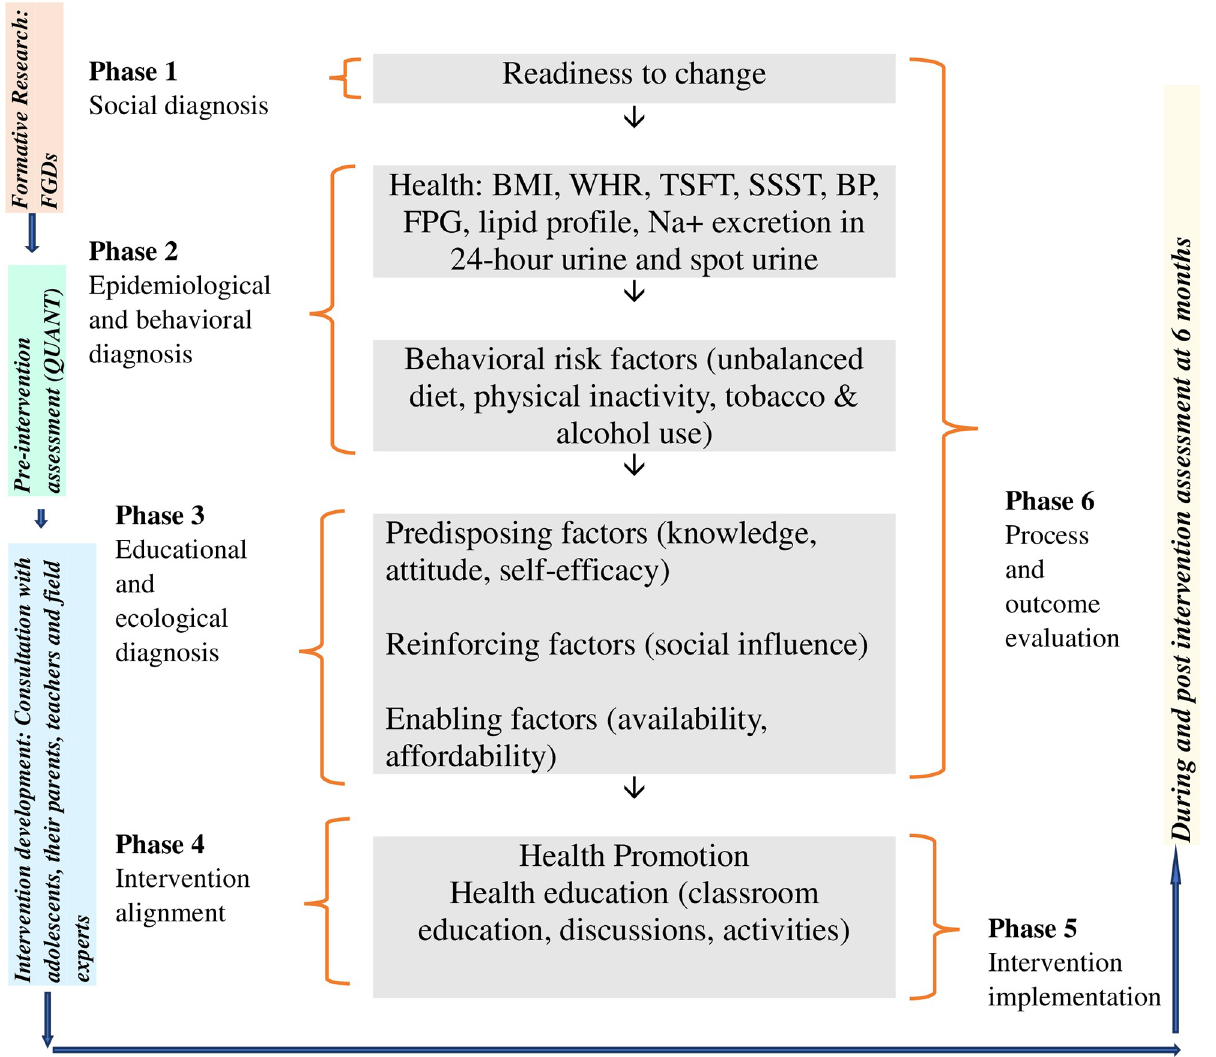
Fig 2. PRECEDE-PROCEED model adapted from Green and Kreuter (1999)